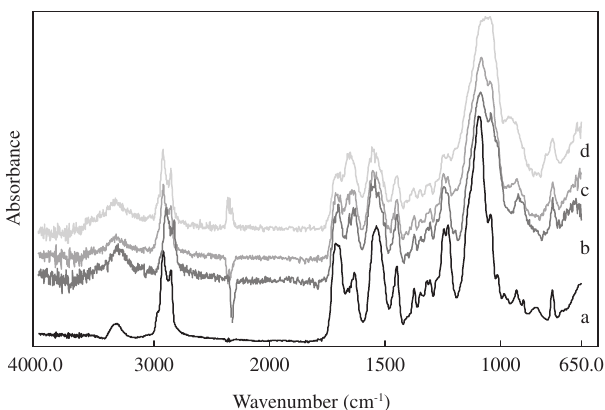
Figure 6. FTIR spectra of a) pure polyurethane containing carboxylic acid groups PU-2 and polyurethanes having inorganic moieties derived from PU-2: b) C2-A; c) C2-C; and d) C2-D.